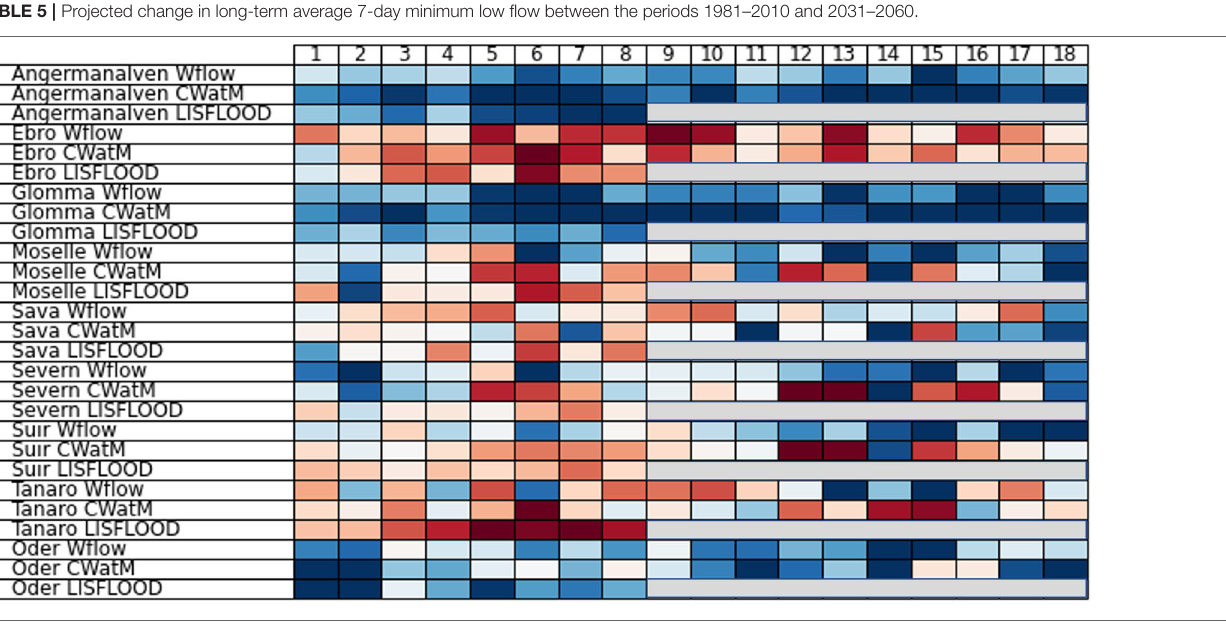
The numbering of the realizations refers to the numbering provided in Table 2 .